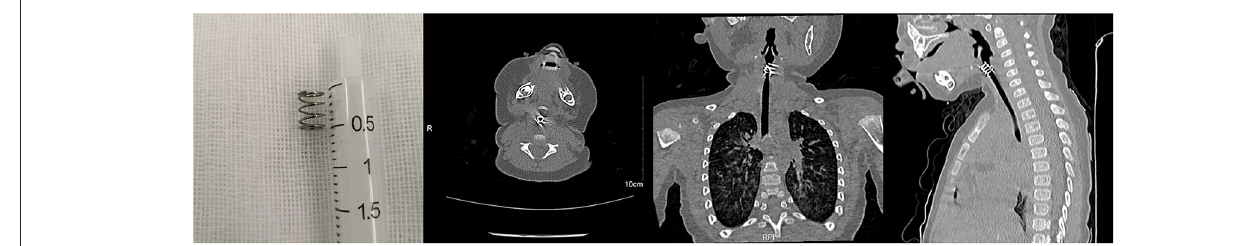
FIGURE 3 | A spring in the glottis of a nine-month-old boy.